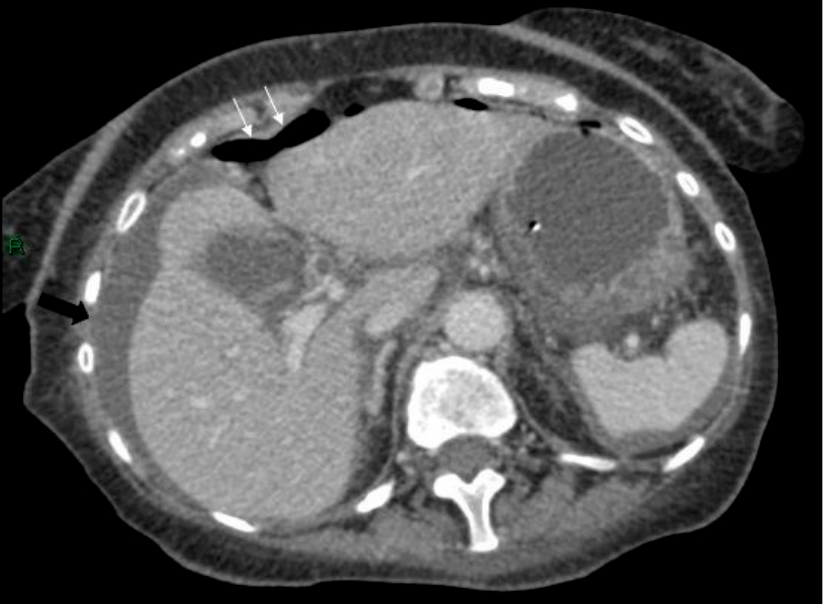
Figure 4. Axial CT scan of abdomen showing free air anterior to the liver (white arrows) and free fluid around the liver and spleen (black arrows).